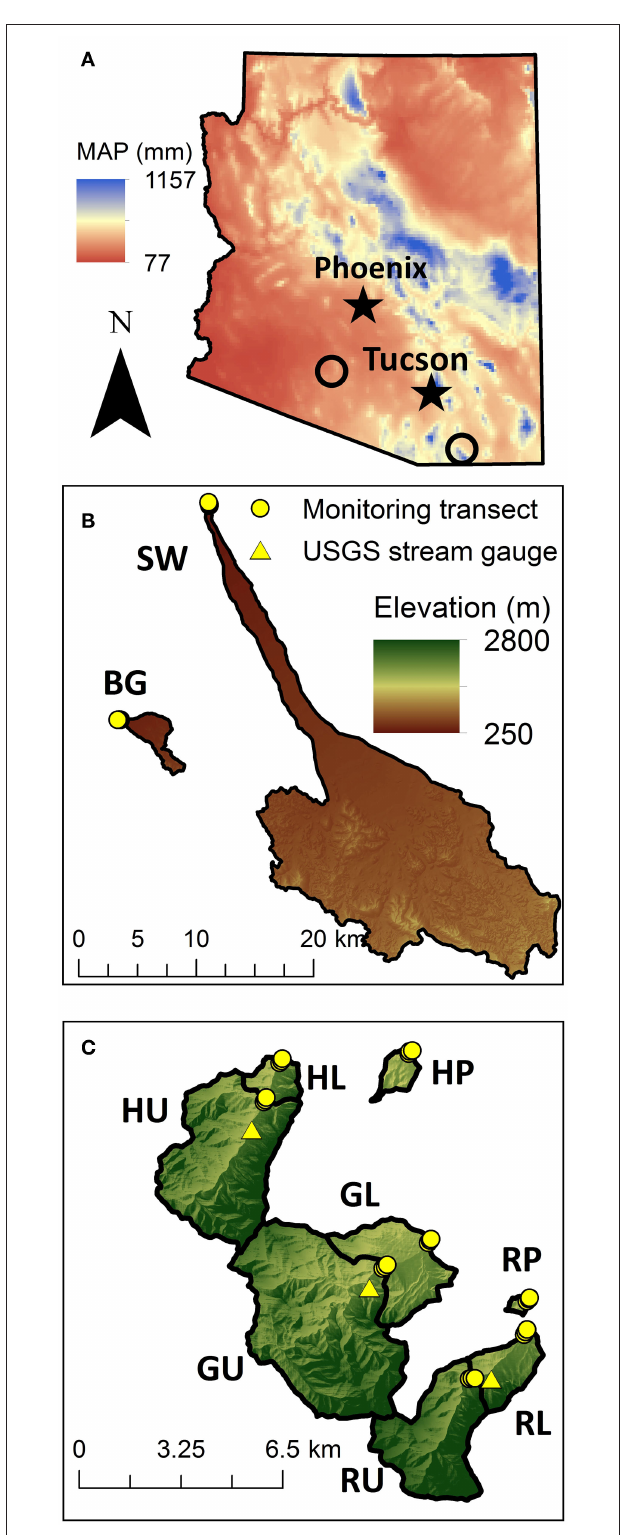
FIGURE 1 | (A) Location of two main study areas in Arizona along a climate gradient with black open circles showing locations of Barry Goldwater and